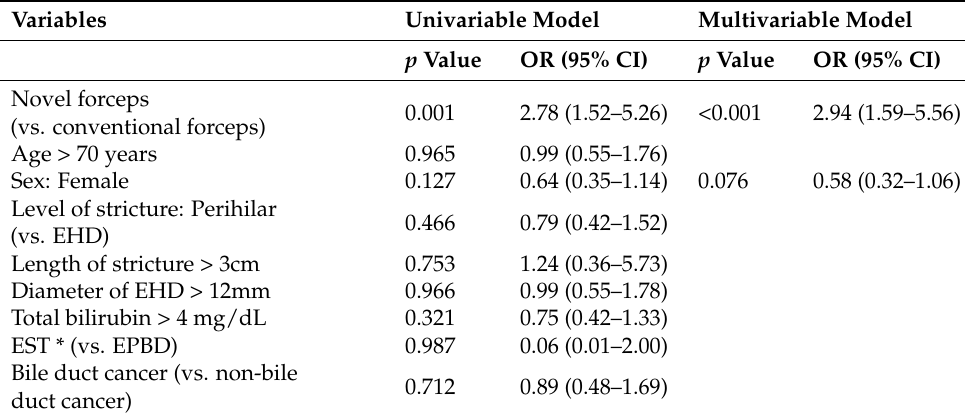
Table 4. Variables for diagnostic accuracy according to univariable and multivariable logistic regres- sion models in malignant